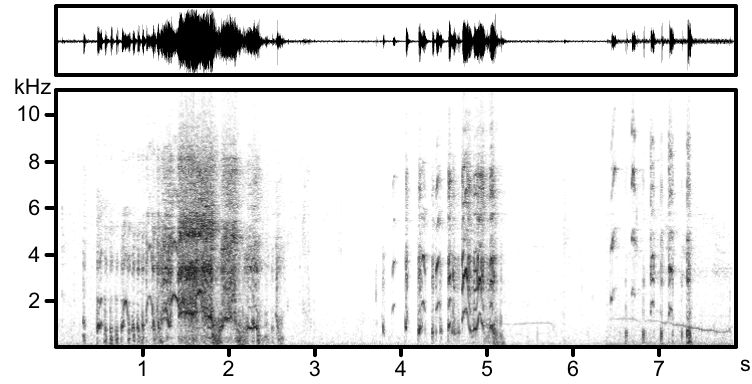
Fig. 1 – Three vocalizations during the same sequential exchange. Each vocalization is formed by a succession of elements emitted by a single individual. The exchange was composed of all three vocalizations, that were emitted without temporal overlap. Note also that the first two vocalizations are initiated by a sequence of short elements that are followed by long elements, and represent neighs. The third vocalization is a staccato, composed solely by short